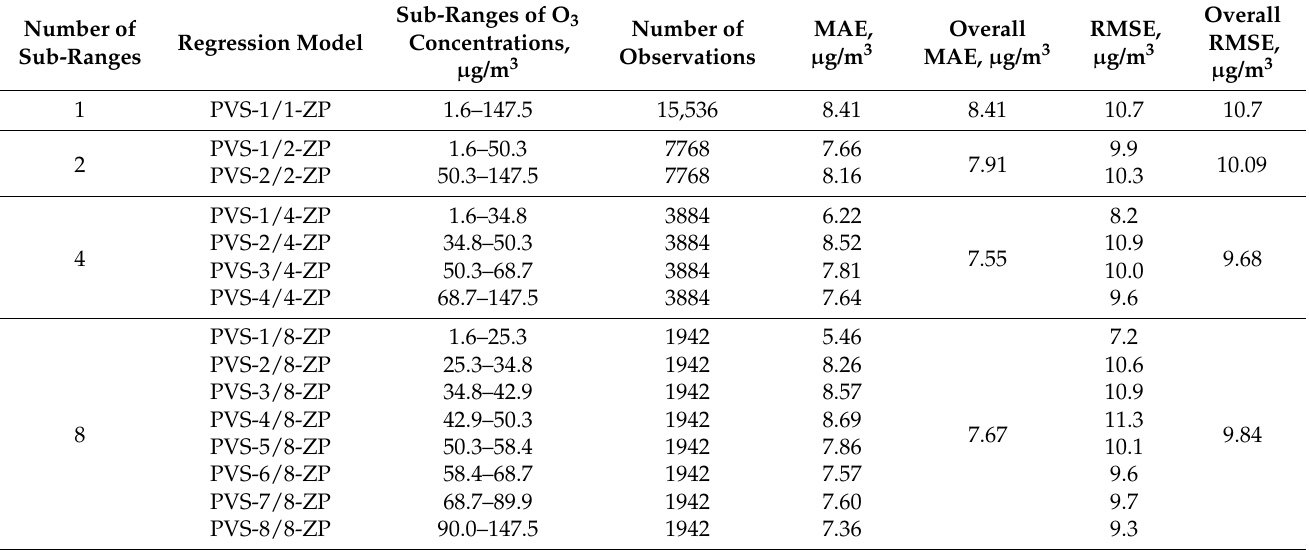
Table 4. Values of approximation errors of O 3 concentrations in PVS models, Złoty Potok